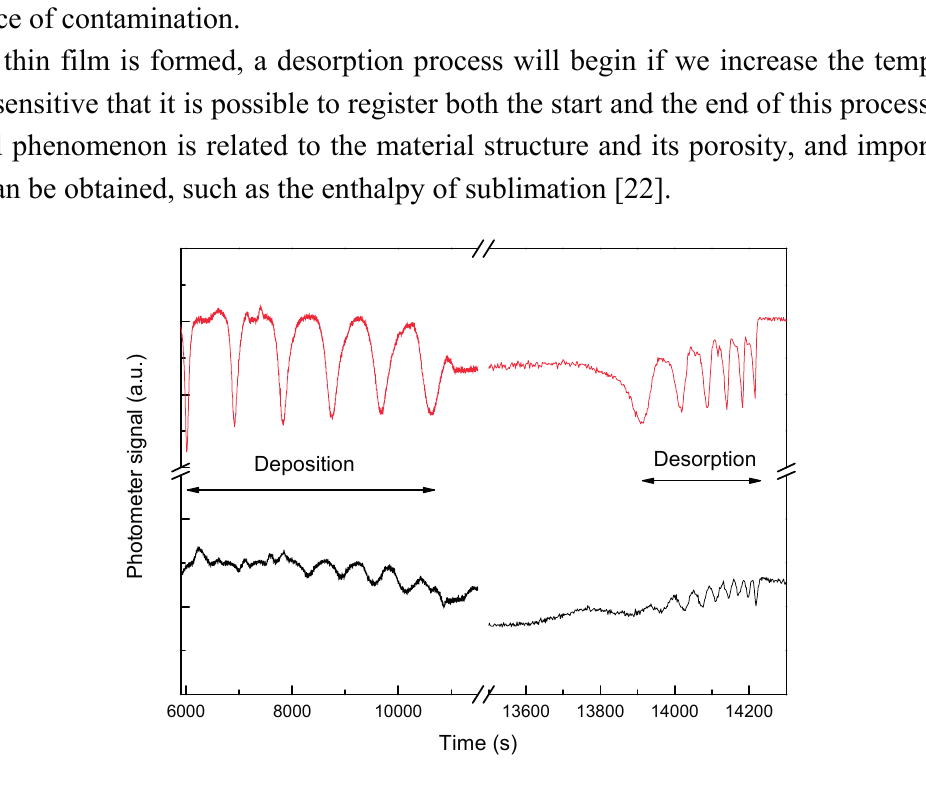
Figure 16. Complete process of thin film deposition and desorption when monitored using two